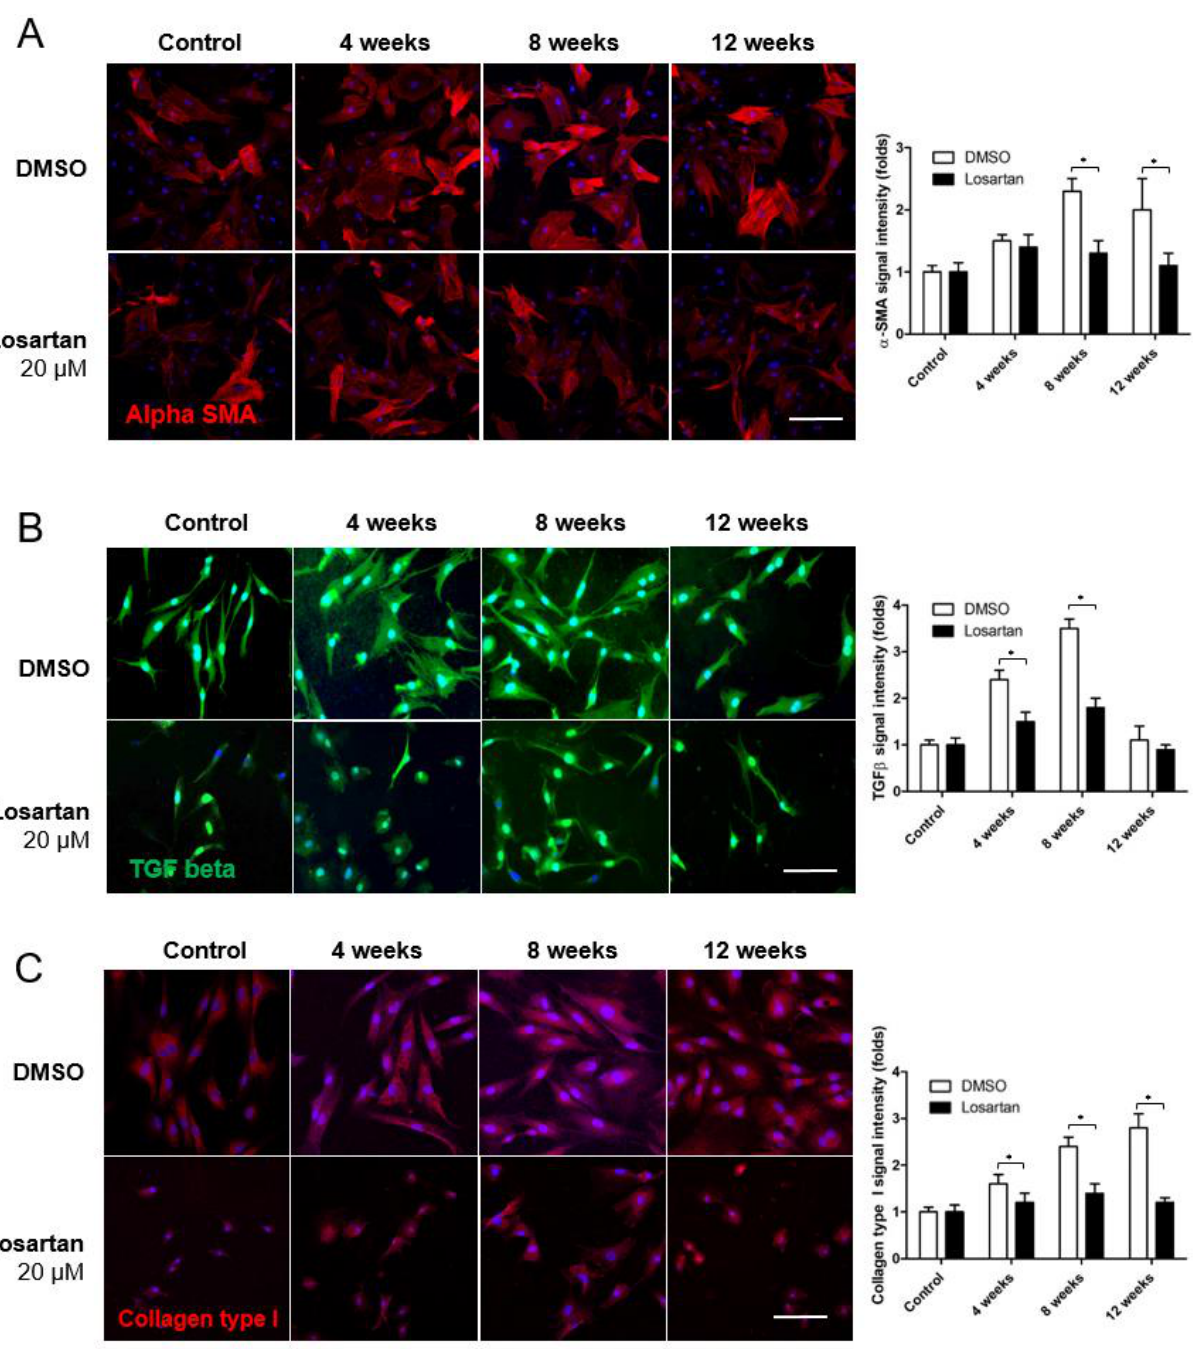
Figure 6. ( A – C ) Immunocytochemical staining of α-SMA, TGF-β, and collagen type I. The expres- to systemic hypotension and was downregulated by the losartan 20 μM treatment. The